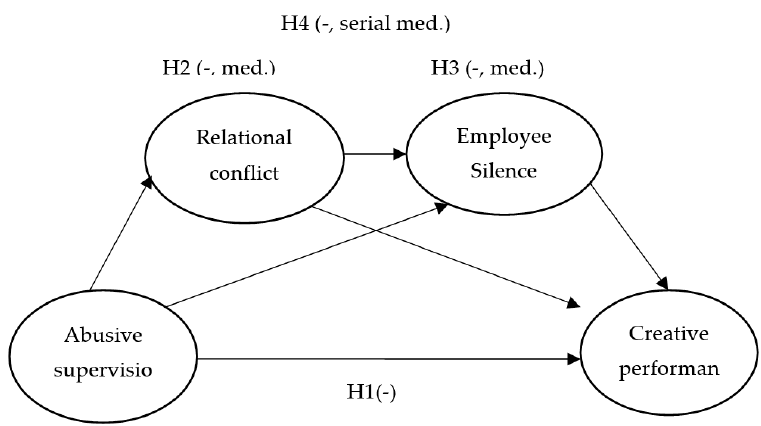
Figure 1. The theoretical research model (made by author,